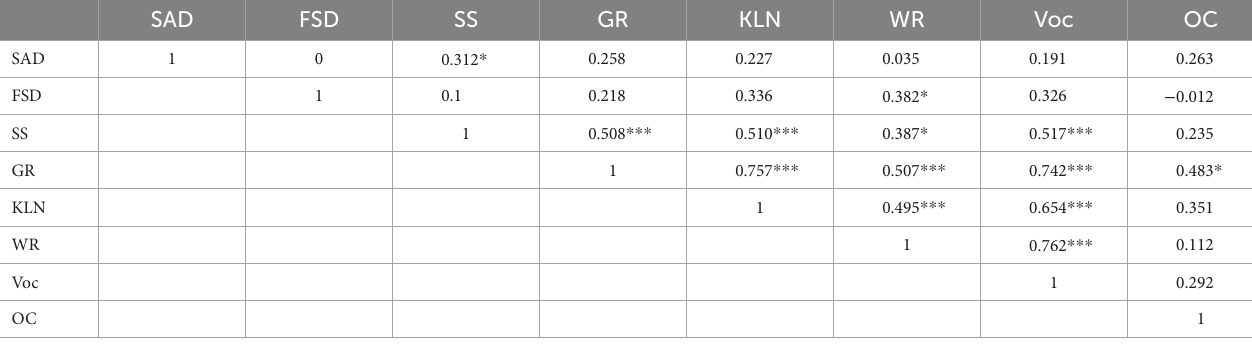
TABLE 4 Partial correlations between variables of interest controlled by age in years.